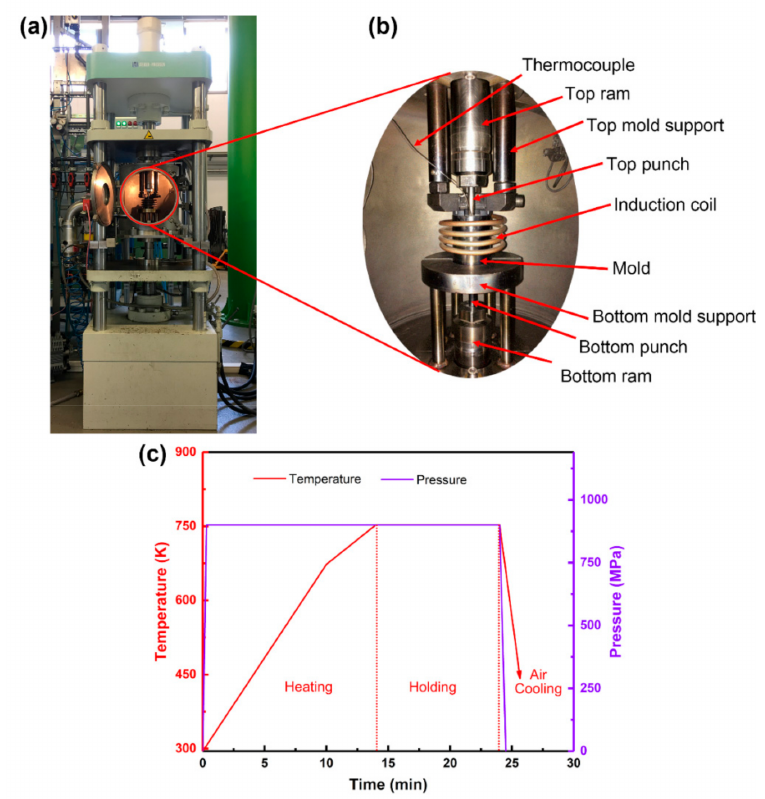
Figure 3. ( a ) The hot-pressing setup and ( b ) close view of the controlled atmosphere chamber. ( c ) Schematic of the hot-pressing